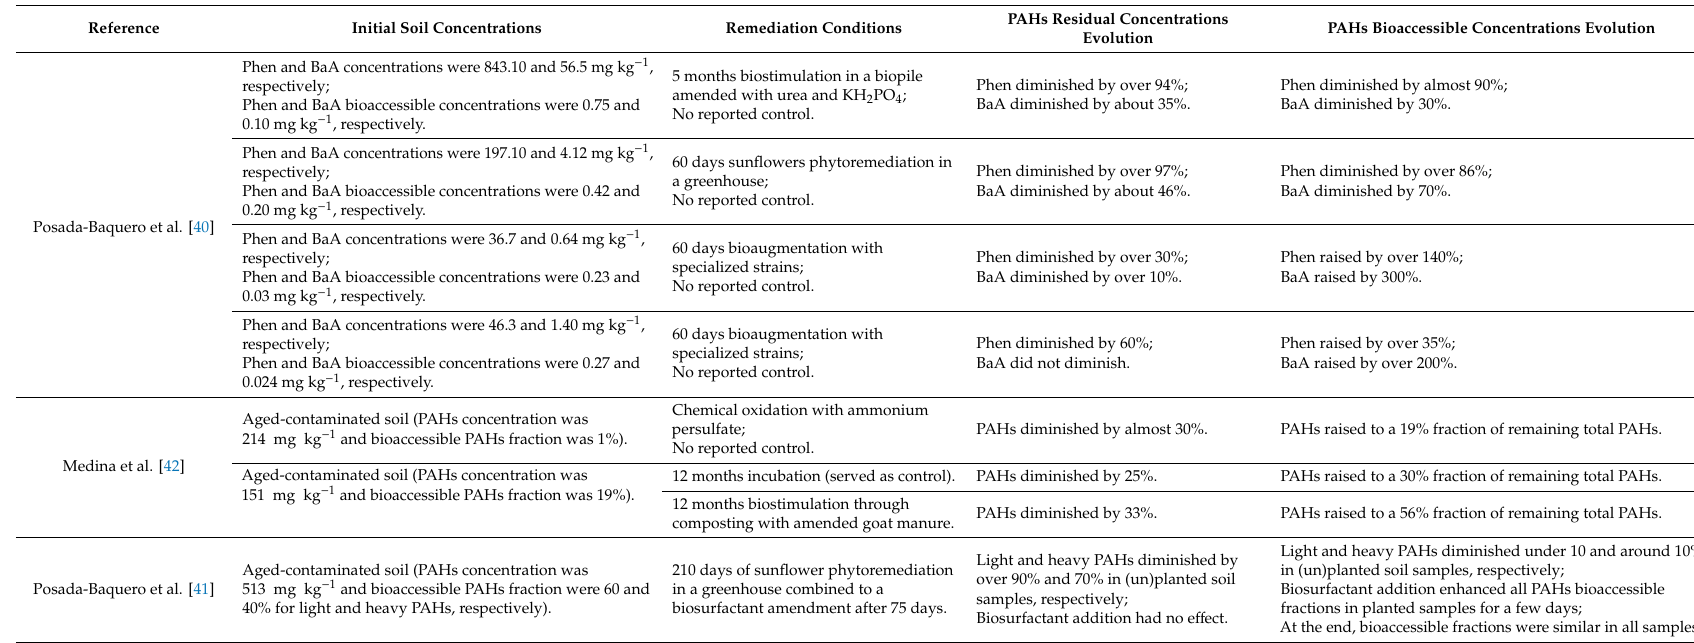
Table 6. Comparison of remediation conditions and outcomes between a few published references for PAHs residual and bioaccessible